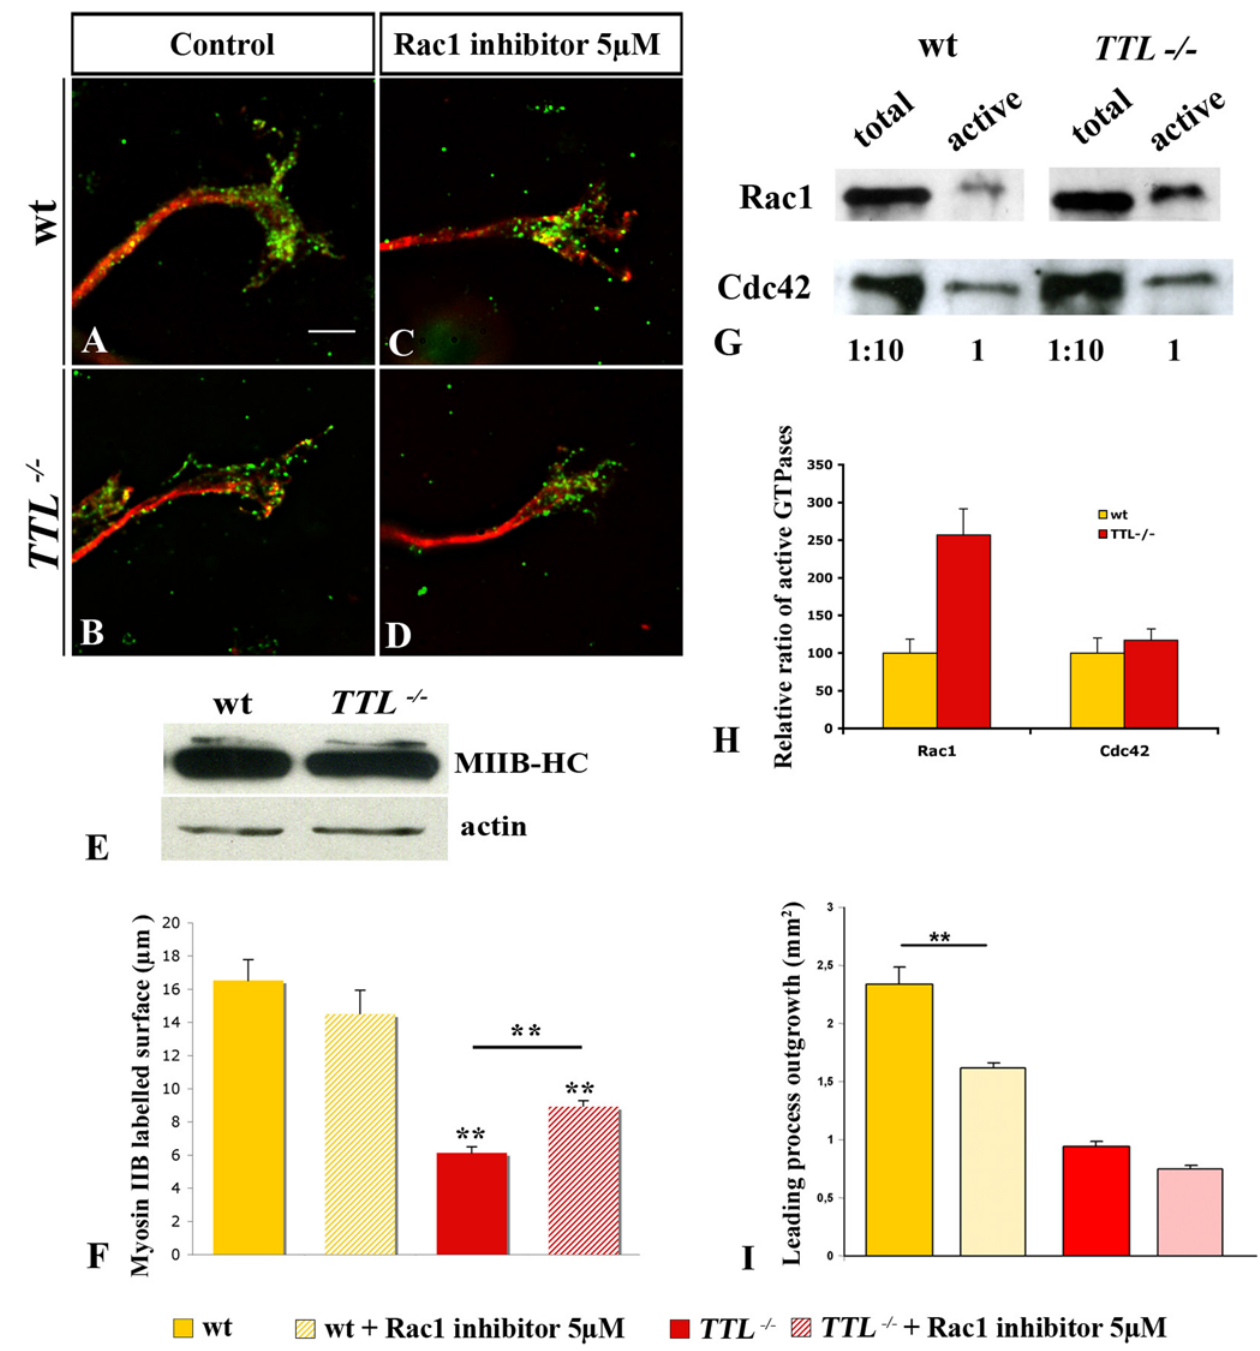
Figure 8. Impaired Myosin IIB recruitment at the growth cone of TTL 2 / 2 neurons. (A–D) Growth cones from E12.5 PCN neurons in collagen assays after 2 DIV. (A, B) Illustrations of double immuno-labeling of Myosin IIB heavy chain (MIIB-HC) (in green) with total a -tubulin (in red) in wt (A) and TTL 2 / 2 (B). MIIB-HC showed a punctuated staining, accumulated in wt growth cones (A), while in TTL 2 / 2 neurons, MIIB-HC distal recruitment was decreased in the growth cone, or even absent is some cases (B). (C, D) When cultured in the presence of 5 m M of Rac1 inhibitor, MIIB-HC still accumulated distally in wt. In contrast, in TTL 2 / 2 neurons, a partial distal recruitement is recovered after treatment with 5 m M of Rac1 inhibitor. (E) The expression level of MIIB-HC in wt and TTL 2 / 2 hindbrains extracts from wt and TTL 2 / 2 E12.5 embryos was analyzed by Western blot revealed with the anti-MIIB-HC antibody. The expression level of MIIB-HC was not affected in the absence of tubulin retyrosination in TTL 2 / 2 neurons. (F) Bar graphs show MIIB-HC labeling quantification using threshold technique and Metamorph analysis. No significant difference could be detected in wt explants cultured in control conditions (n=31) and drug treated (n=20). In TTL 2 / 2 growth cones, MIIB-HC is significantly mis-localized (n=40). The distal part of TTL 2 / 2 axons cultured with Rac1 inhibitor show a partial but significative rescue of MIIB-HC recruitment (n=45). (G) Quantification of Rac1 and Cdc42 GTPases activity in E12.5 wt and TTL 2 / 2 hindbrains. (H) Bar graphs show the quantification of the relative active state of each GTPase upon Western blotting quantification in both wt (yellow) and TTL 2 / 2 (red) lysates. The ratio of active GTPases in TTL 2 / 2 versus wt hindbrains showed an increase of Rac1 activation whereas the ratio of Cdc42 activation remained unchanged when tubulin retyrosination was defective. (I) Bar graphs show quantification of axon outgrowth from wt and TTL 2 / 2 explants with or without 5 m M of Rac1 inhibitor. ** P , 0,001. Scale bar: 2 m m.